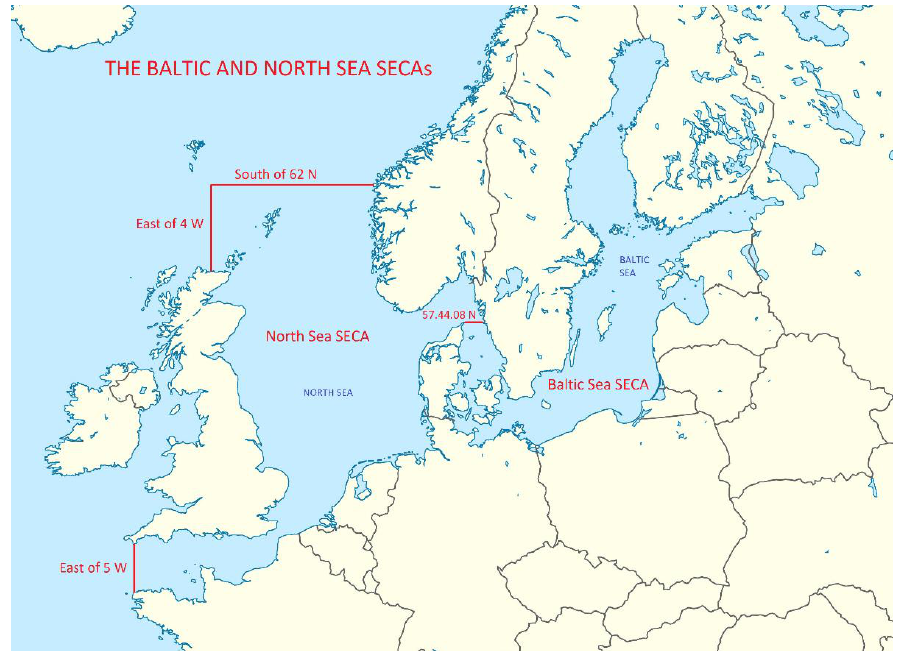
Figure 3. Baltic and North Sea ECAs.